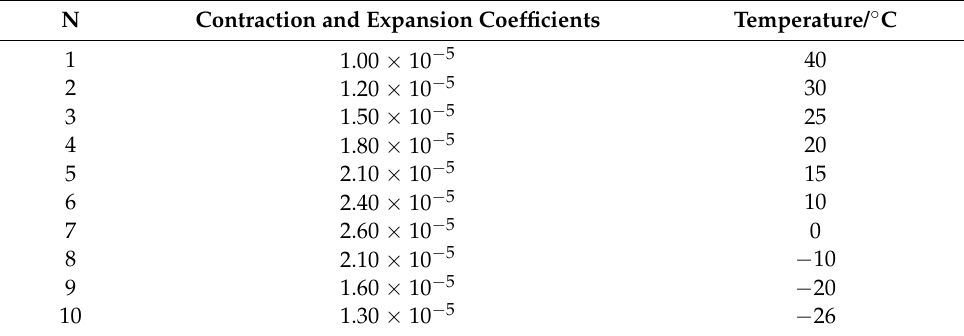
Table 6. Thermal contraction and expansion